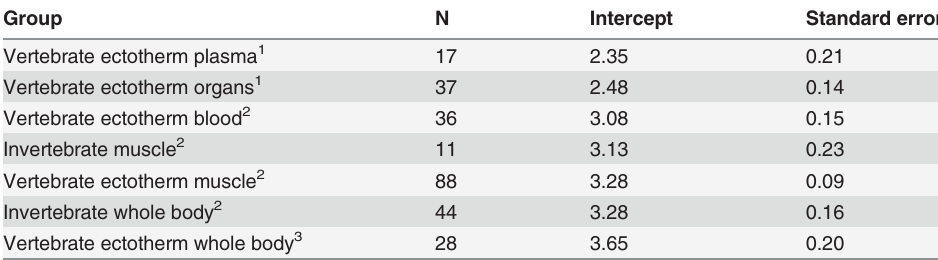
Vertebrate ectotherm whole body 3 0.20 Half-life for ectotherm groups (tissue type-taxon combinations) was described by a model with a common slope (0.22) with body mass and group-speci fi c intercepts. 1 – 3 indicates groupings based on the absence of signi fi cant differences (p = 0.05) among group- speci fi c